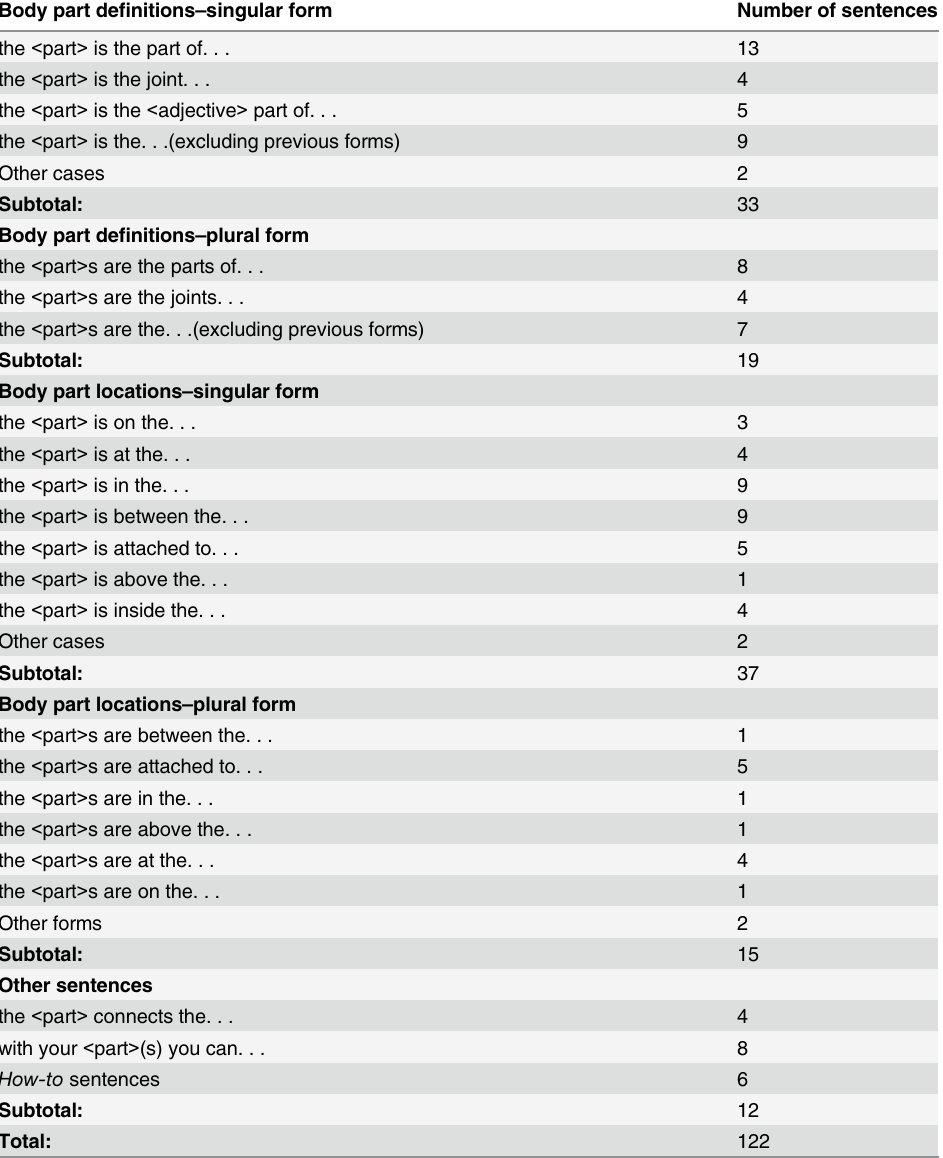
Table 2. Sentences of the parts-of-the-body dataset. Thirty-three body parts are included in the dataset. In the first column, < part > is the name of a body part. The “ (s) ” refers to a possible plural form. Body part de fi nitions – singular form Number of